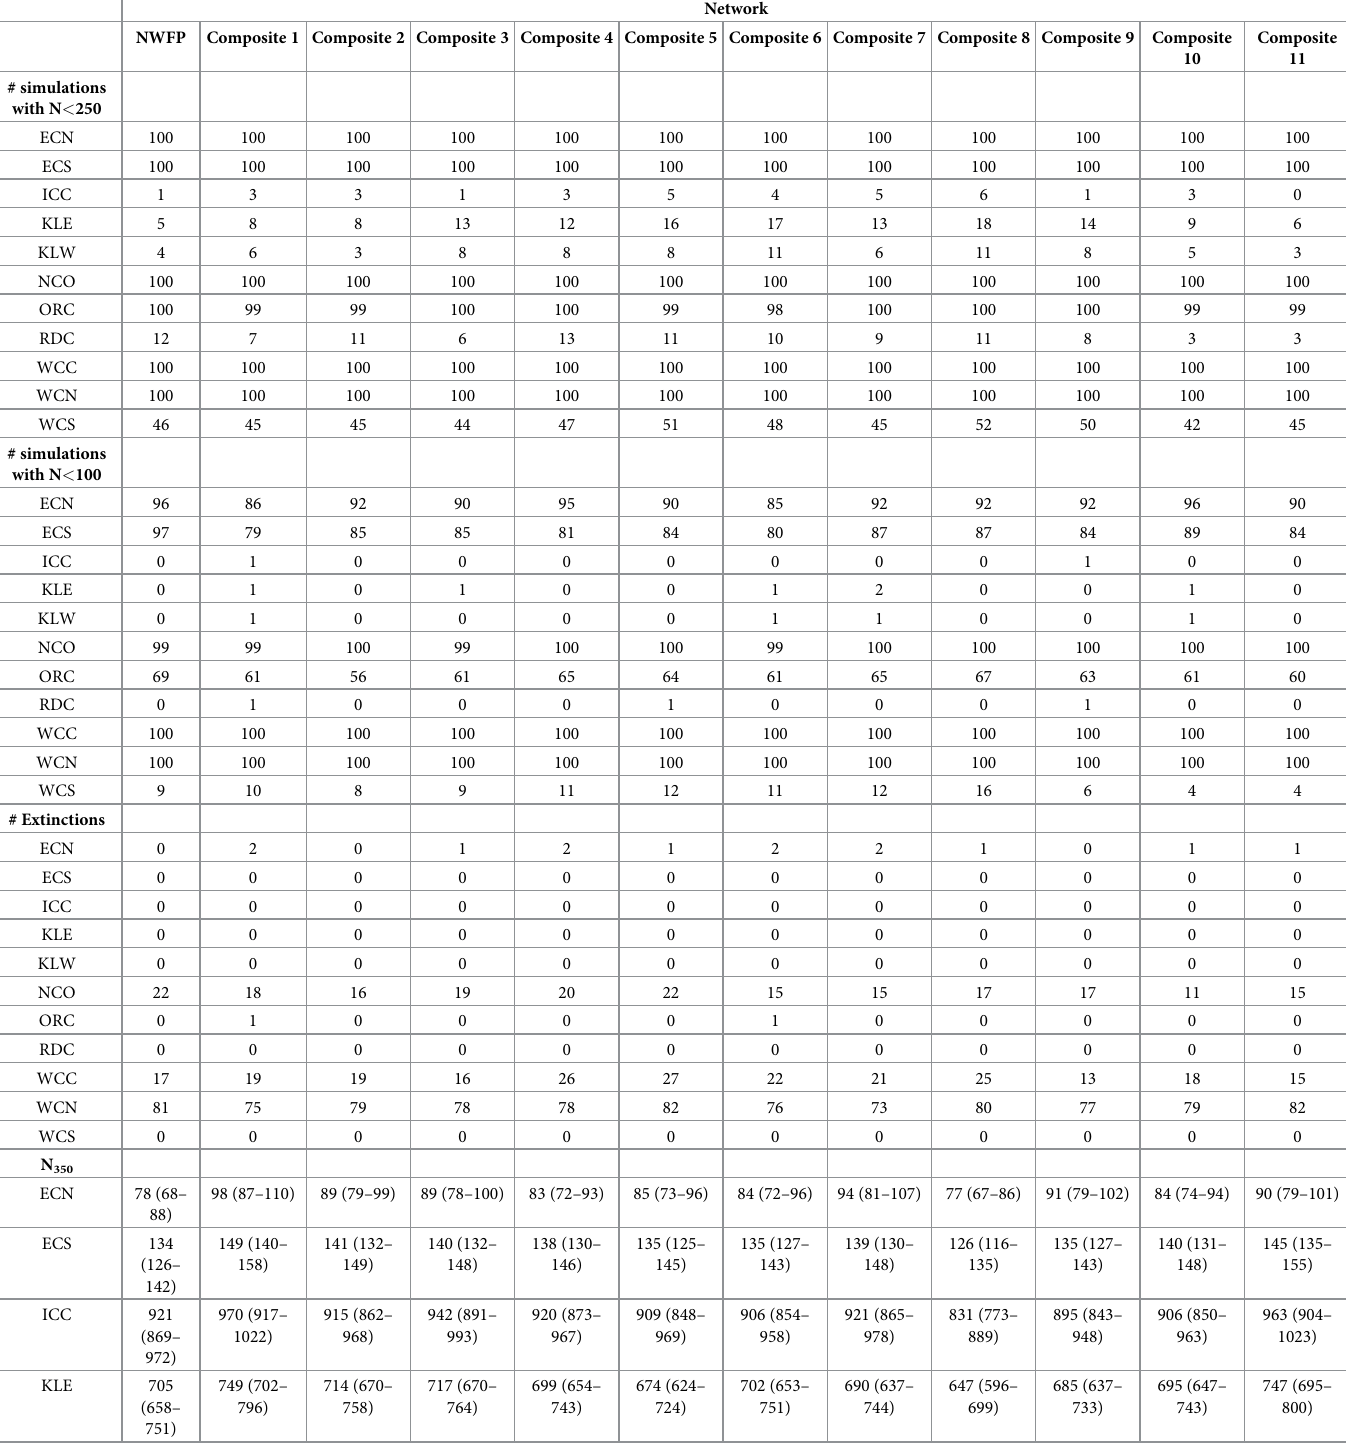
Table 11. Estimated northern spotted owl population responses, in modeling regions, among candidate critical habitat networks for the optimistic relative habitat suitability change scenarios.